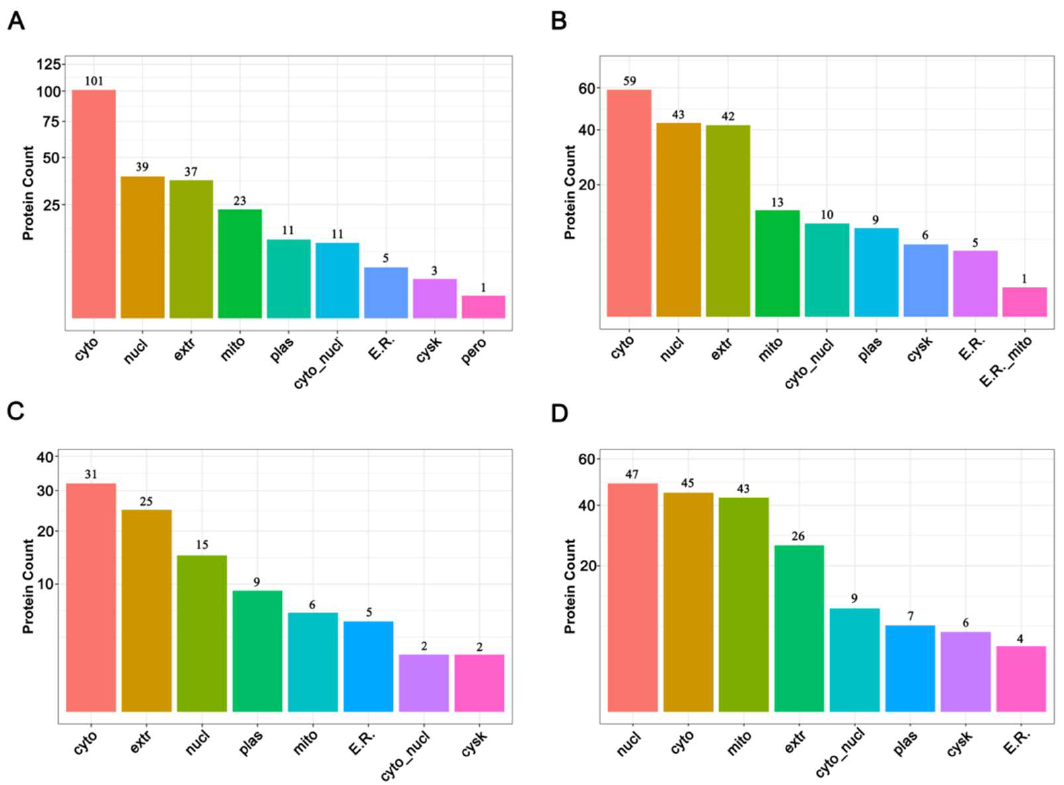
Figure 4. Subcellular location of DAPs before and after thermal induction. ( A ) Subcellular location of increased abundance proteins before thermal induction; ( B ) Subcellular location of decreased abundance proteins before thermal induction; ( C ) Subcellular location of increased abundance proteins after thermal induction; ( D ) Subcellular location of decreased abundance proteins after thermal induction.